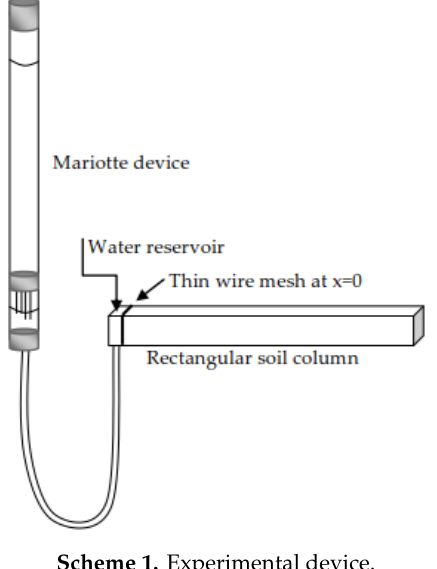
Scheme 1. Experimental device.